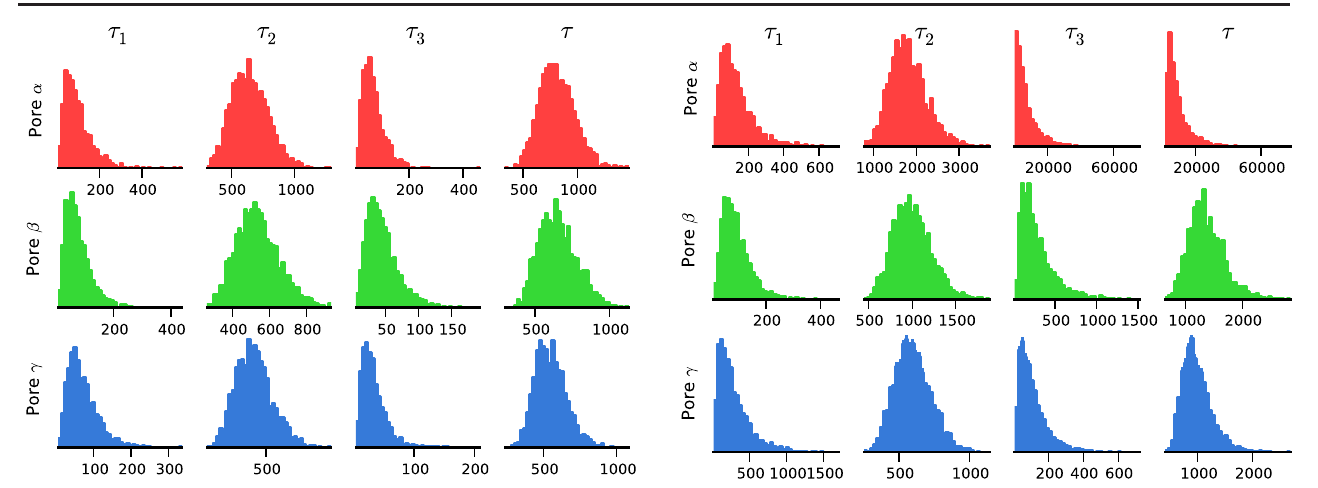
.FIG. 6. Comparison of the filling, transfer, escape, and translocation time distributions for the three pores at F ¼ 0 : 5 and (cid:1) ¼ 1 : 0 .